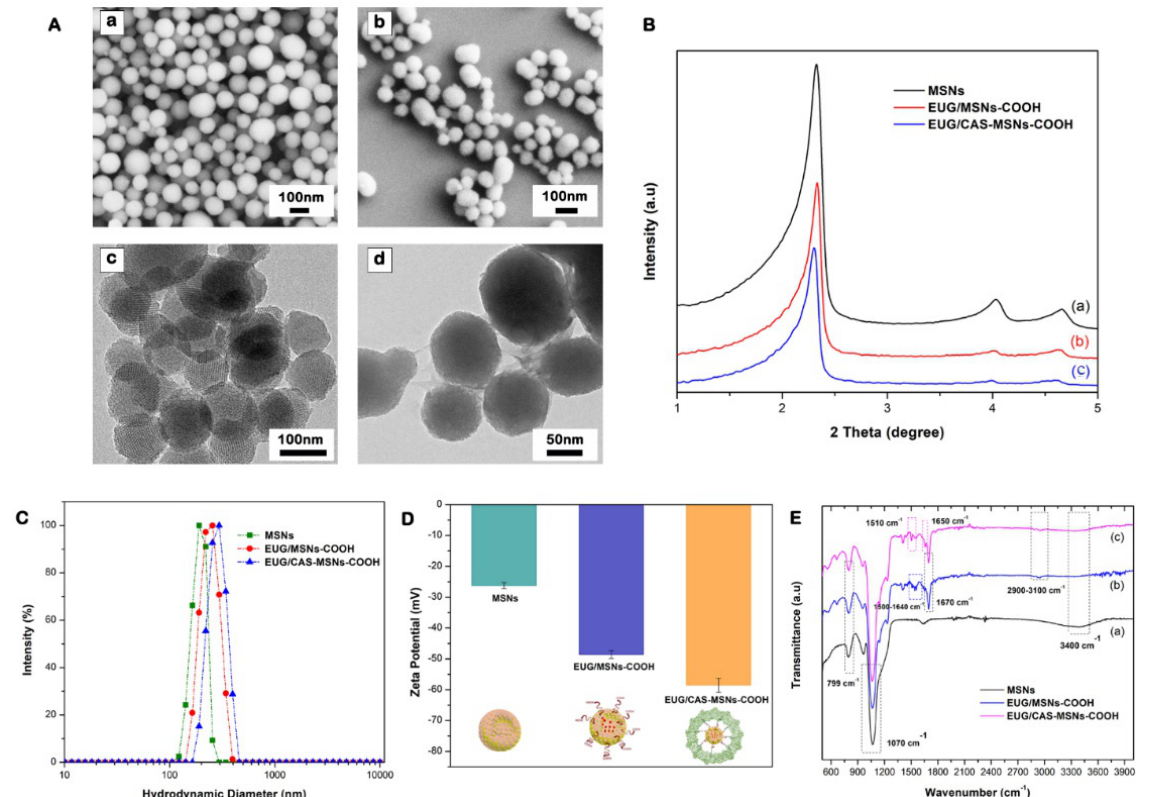
Figure 6. Synthesis and characterization of casein-capped controlled eugenol delivery system ( A ) SEM and TEM images, subpanels ( a , b ) illustrate SEM images of MSNs and EUG/CAS-MSNs–COOH, respectively. Subpanels ( c , d ) illustrate TEM images of MSNs and EUG/CAS-MSNs–COOH, respectively. ( B ) XRD patterns, ( C ) zeta size distribution, ( D ) zeta potential at pH 7.4, ( E ) FTIR spectra of for MSNs, EUG/MSNs–COOH, and EUG/CAS-MSNs–COOH.